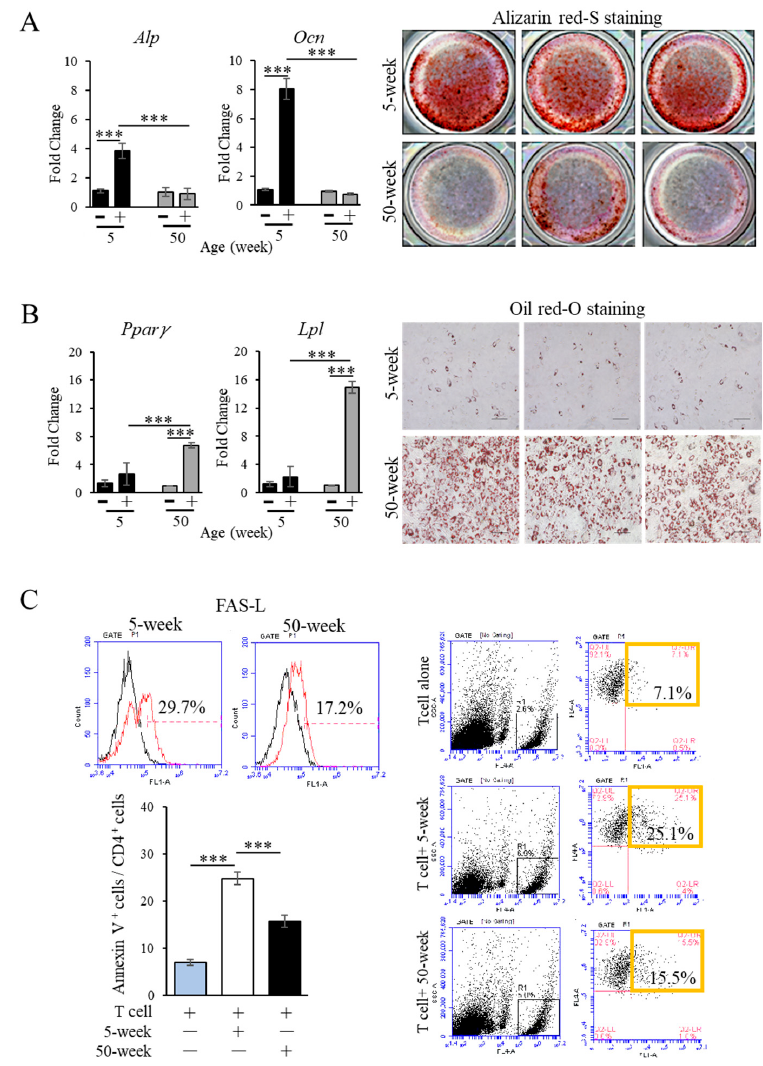
Figure 6. Reduced osteogenic di ff erentiation and immunomodulation in aged MSCs. ( A ) Alizarin red-S staining showing less ability of mineral deposition by aged MSCs compared to young MSCs after osteogenic induction for 21 days. The expression of osteoblast marker genes ( Alp, Ocn ) was determined by real-time RT-PCR. Note the weak staining for alizarin red-S and unchanged expression of Alp and Ocn in aged MSCs cultured in osteogenic medium for 21 days, indicating the low osteogenic differentiation ability of the aged cells. The bar graph represents the mean ± standard deviation of at least 3 independent samples. *** p < 0.001, one-way ANOVA, Tukey test, n = 3. Alp : Alkaline phosphatase, Ocn : Osteocalcin. ( B ) Oil red-O staining showing a dramatically increased formation of lipid droplets by aged MSCs compared to young MSCs. Bar: 100 µm. The expression levels of early adipogenic differentiation markers ( Ppar γ and Lpl ) were significantly higher in aged than in young MSCs. The bar graph represents the mean ± standard deviation of at least 3 independent samples. *** p < 0.001, one-way ANOVA, Tukey test, n = 3. Ppar γ : Peroxisome proliferator-activated receptor γ , Lpl : lipoprotein lipase. ( C ) Flow cytometric analysis showing a decreased expression of FAS-L in aged MSCs (upper left panel). After co-culture, young and aged MSCs could induce apoptosis of CD4 + T cells, as determined by flow cytometric analysis of Annexin V + apoptotic T cells (lower left graph and right panel). Note that the ability of aged MSCs to induce T cell apoptosis is significantly reduced compared to young MSCs. The bar graph represents the mean ± standard deviation of at least 3 independent samples. *** p < 0.001, one-way ANOVA, Tukey test, n = 3.